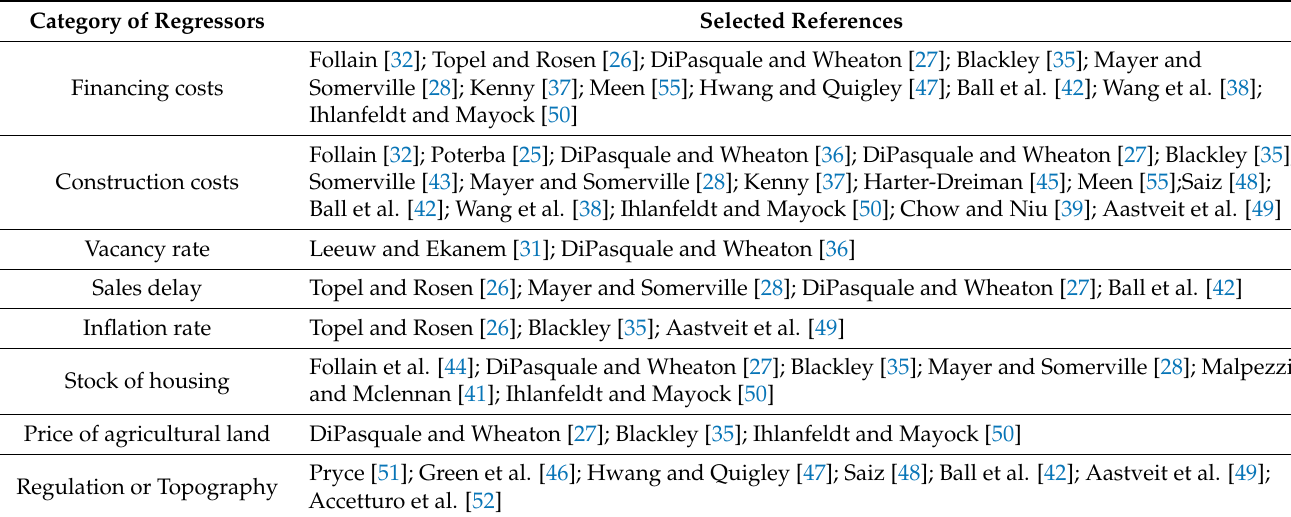
Table 3. Selected references for each category of